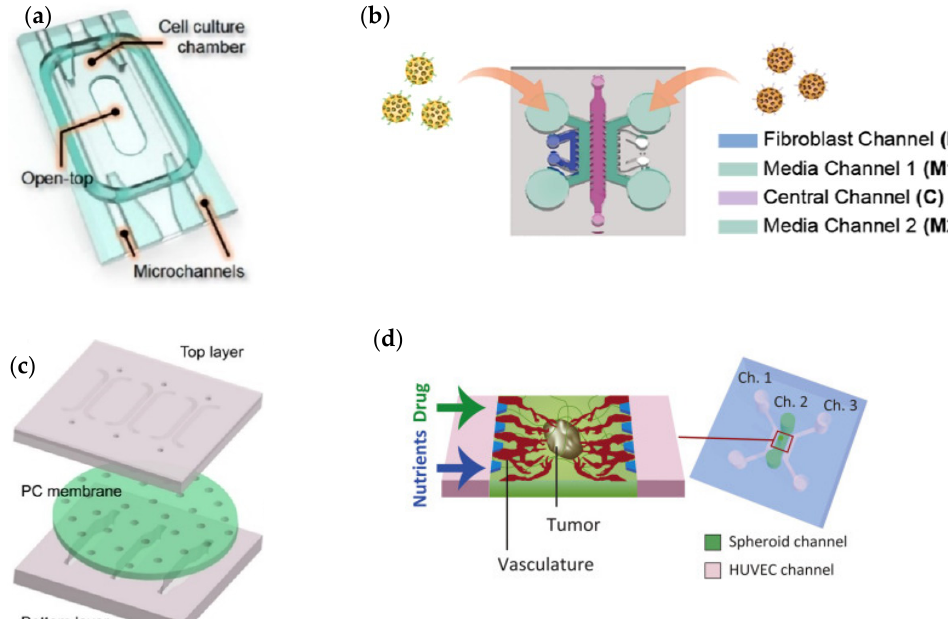
Figure 5. ( a ) Paek et al. [38] proposed the a device comprising a cell culture chamber with a top opening and two parallel microchannels used for controlled vascular perfusion. Adapted with permission from [38]; ( b ) Lee et al. [39] design a chip for angiogenesis assay. Adapted with permission from [39]; ( c ) a microfluidic chip design by Wang et al. [40] constructed with top and bottom layers separated by PC membrane. Adapted with permission from [40]; ( d ) Microfluidic platform to recapitulate in vivo tumor microenvironments, proposed by Nashimoto et al. [41]. Adapted with permission from [41].